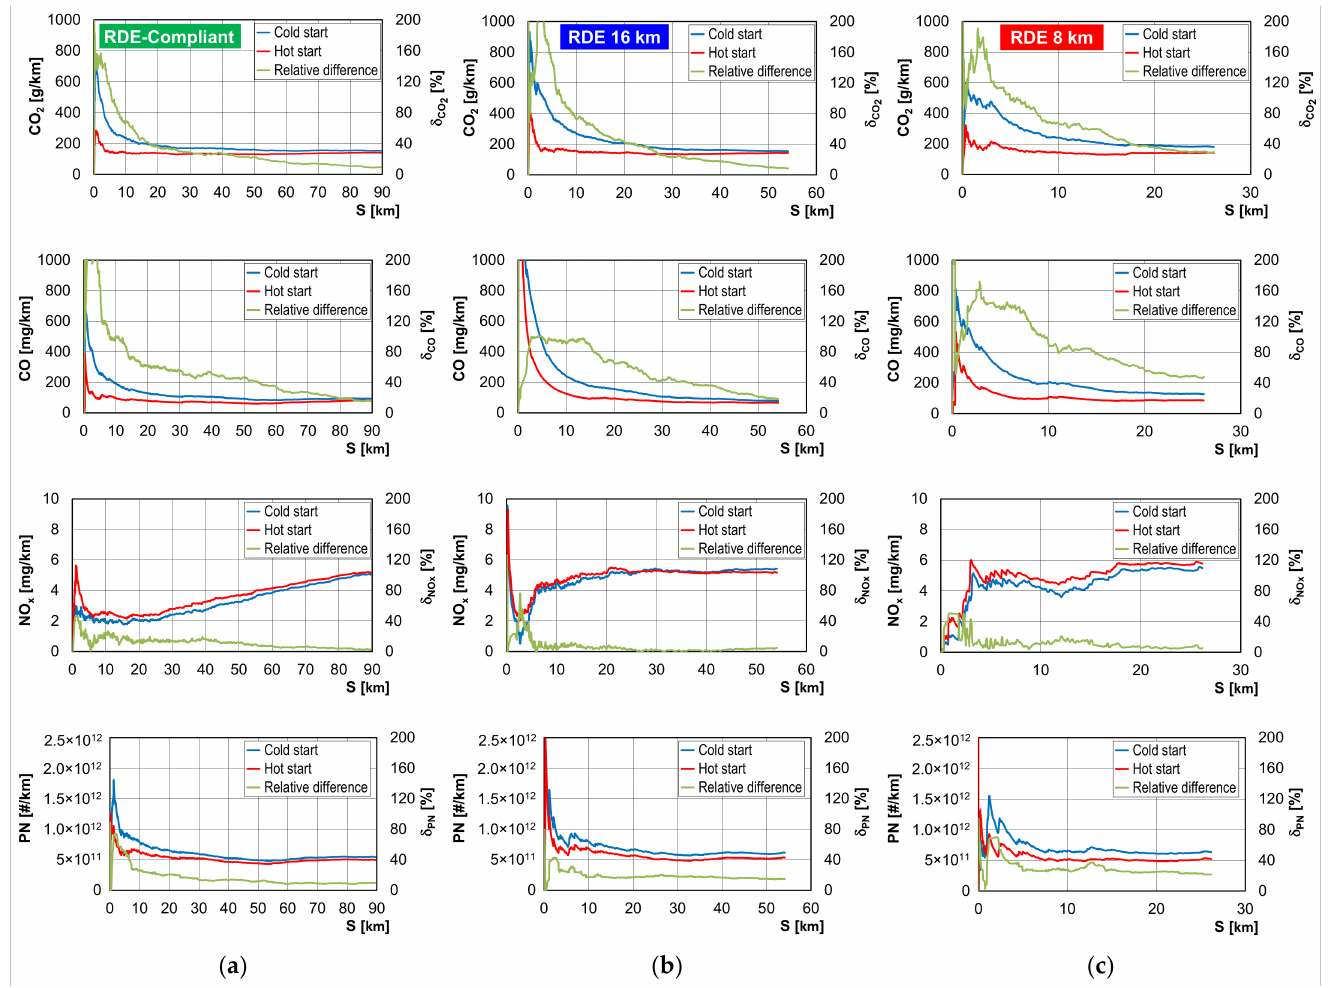
Figure 6. Comparison of on-road emissions by test road: ( a ) RDE-Compliant, ( b ) RDE 16 km, ( c ) RDE 8